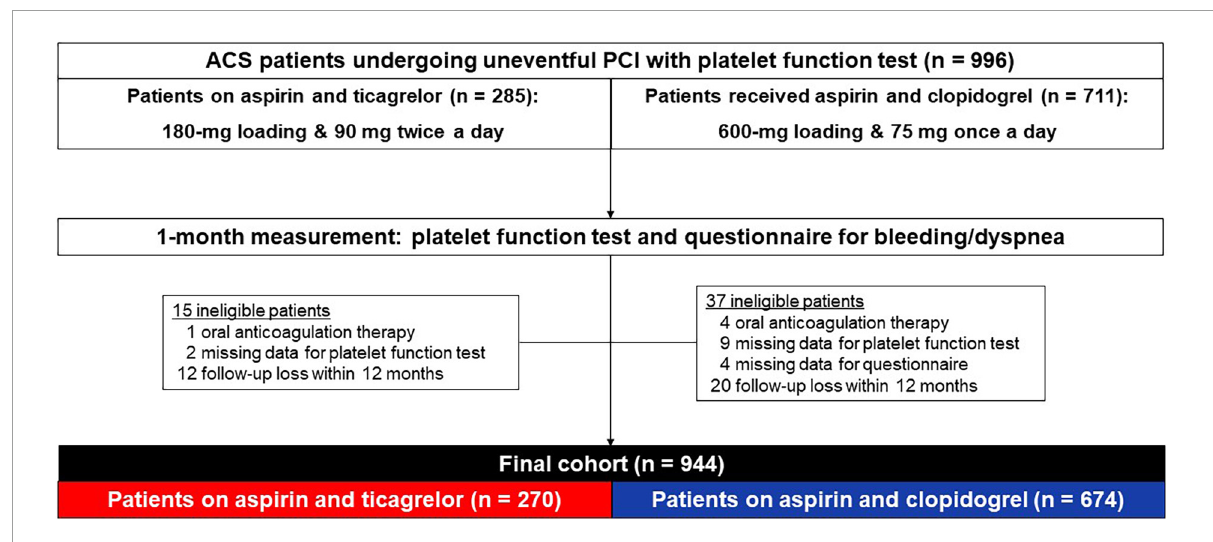
Dyspnea was categorized by using modified Medical Research Council (mMRC) scale (19) ( Table 1 ). Classification of BARC bleeding type and mMRC dyspnea grade were performed by the main investigators (M. G. Kang and Y-H.